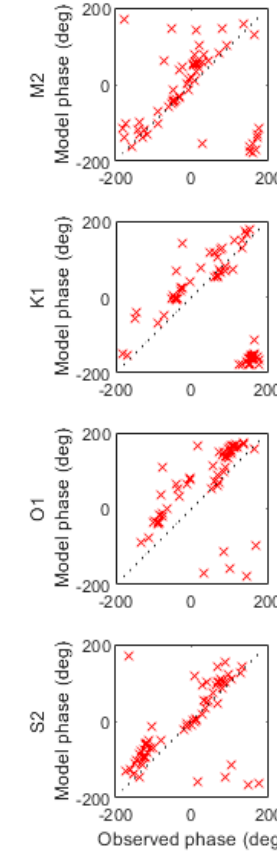
Figure 8. Comparison of tidal amplitude and phase for tidal constituents M2, K1, O1 and S2.